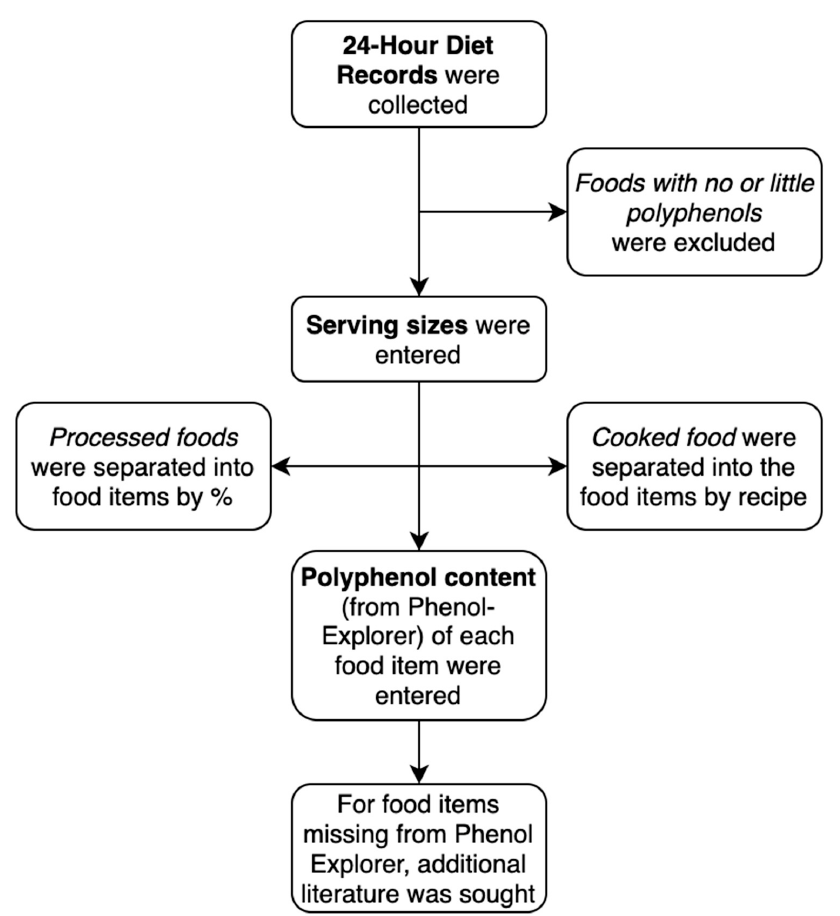
Figure 1. Method for the extraction of total polyphenol intake from the 24-HDR (24-h dietary recall).